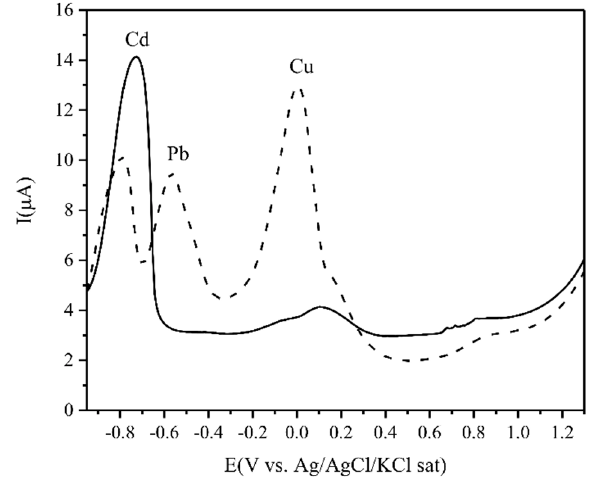
Figure 9. DPV of a mixture of other metal cations on CPE modified with PAA-co-IA / NaOH / B-MWCNT hydrogel in a solution of 3 ppb (2.67 × 10 − 8 M) Cd(II) (solid line) and 3 µ gL − 1 each of Cd(II), Zn(II), Hg(II), Pb(II), and Cu(II) (dot line) + 0.1 M KNO 3 at pH 5. The accumulation time was 10 min